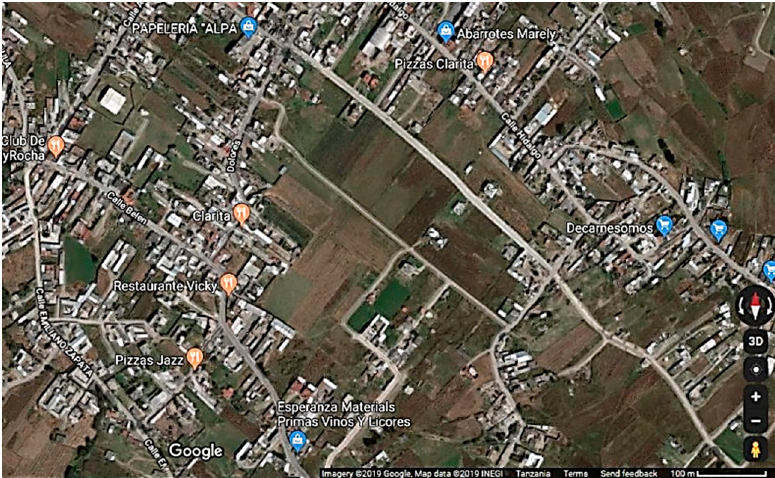
Figure 7. Informal housing in Ejido in Santa Clara Ocoyucan. Source: Google Maps (accessed 23 July 2019). Land use: Rural–informal; Tenure System: Regularized ejido ; Stakeholders: Ejidatarios , Landowners, Local authorities, Regularization agency (Institute for Sustainable Land).